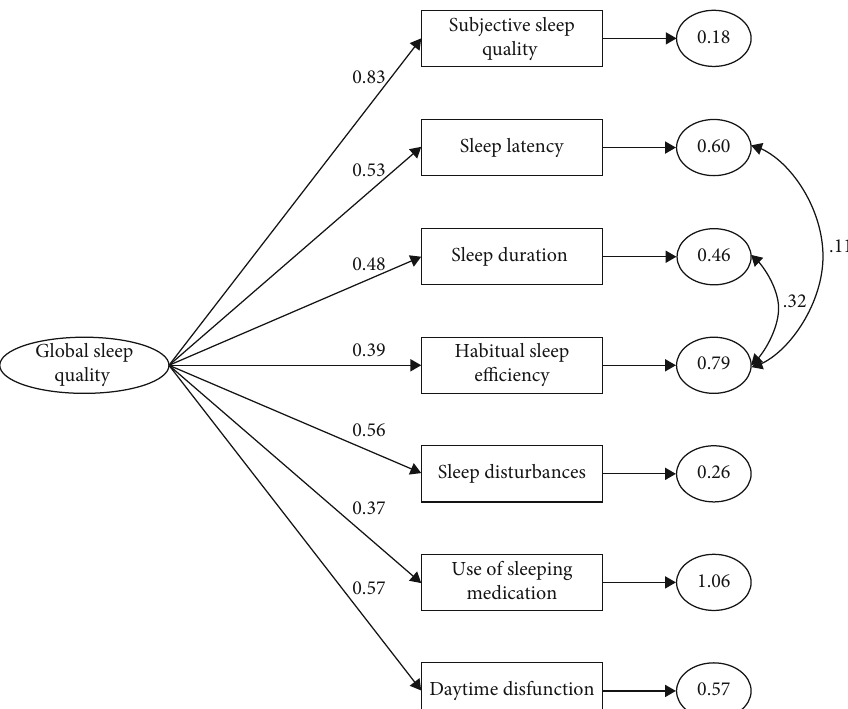
Figure 1: Final Pittsburgh Sleep Quality Index single-factor model, with all maximum likelihood estimates (standardized estimates) and error terms signi fi cant at p < : 001